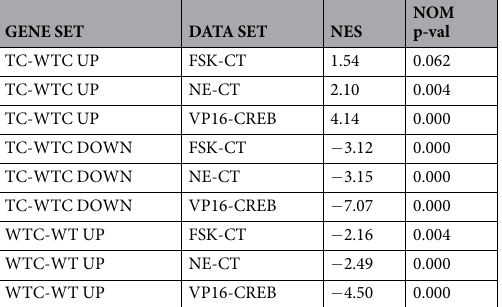
Table 1. GSEA of in vitro DEG-Q1-TRAP lists in Gfa2-TtA/TetO-VP16-CREB mice. In vitro databases were compared with UP and DOWN genes in injured transgenic (TC) vs injured WT mice (WTC), and with